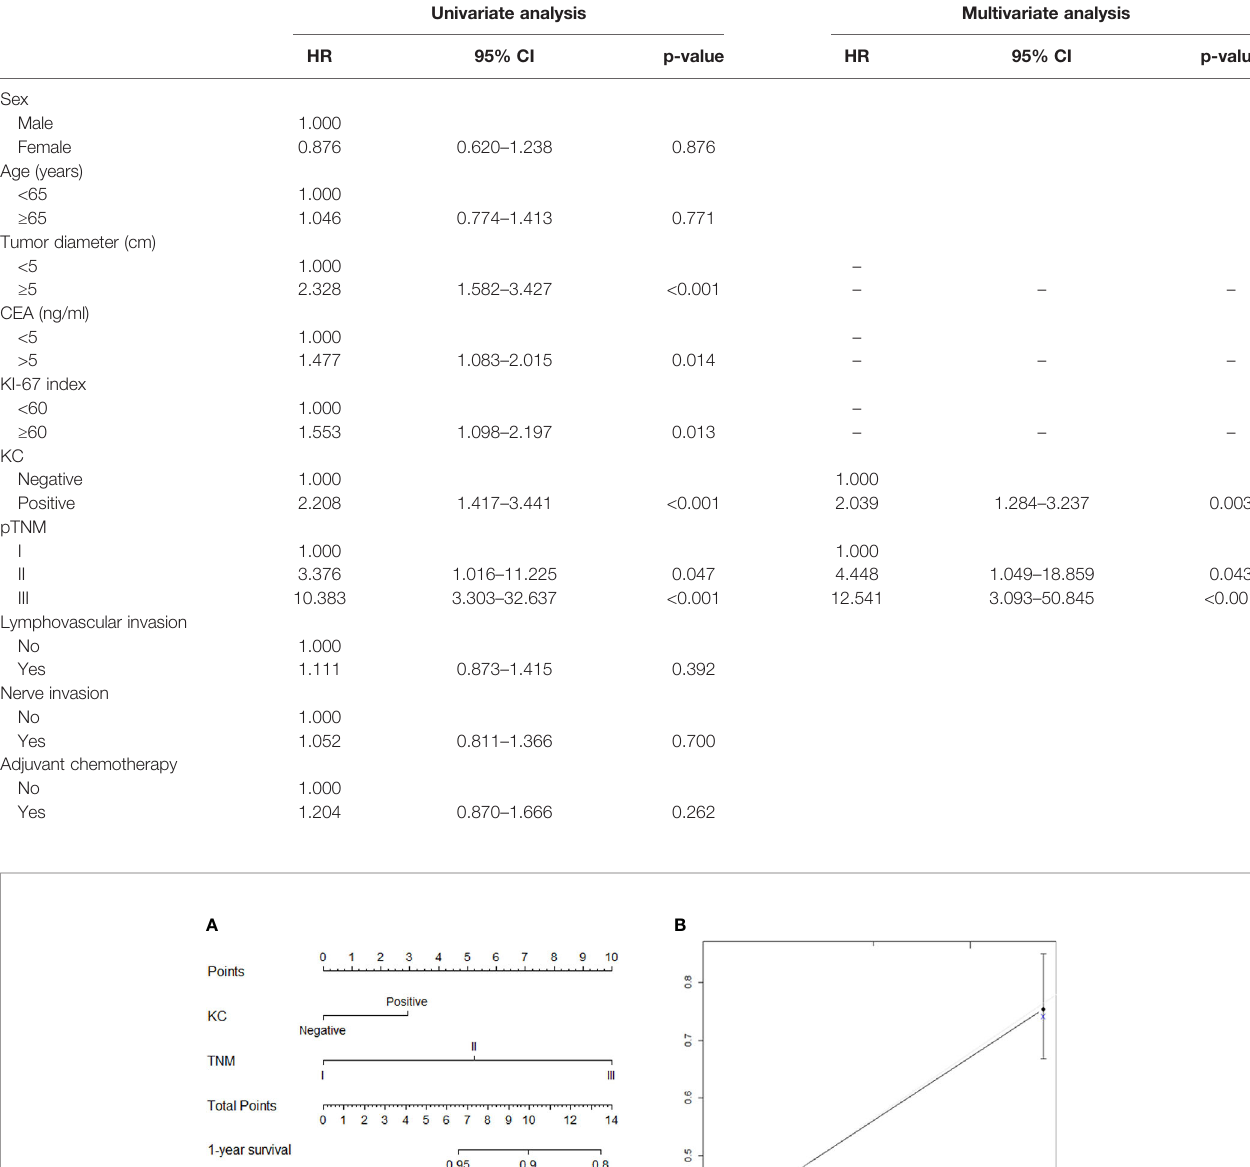
TABLE 2 | Univariate and multivariate analyses of the factors associated with overall survival.